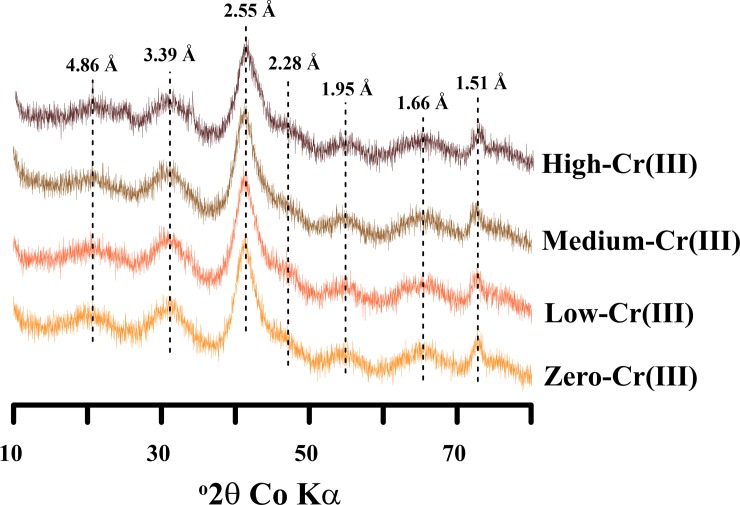
X-ray diffraction patterns of the initial schwertmannite specimens examined in this study.Schwertmannite peaks with d-spacing values are denoted with dotted lines.